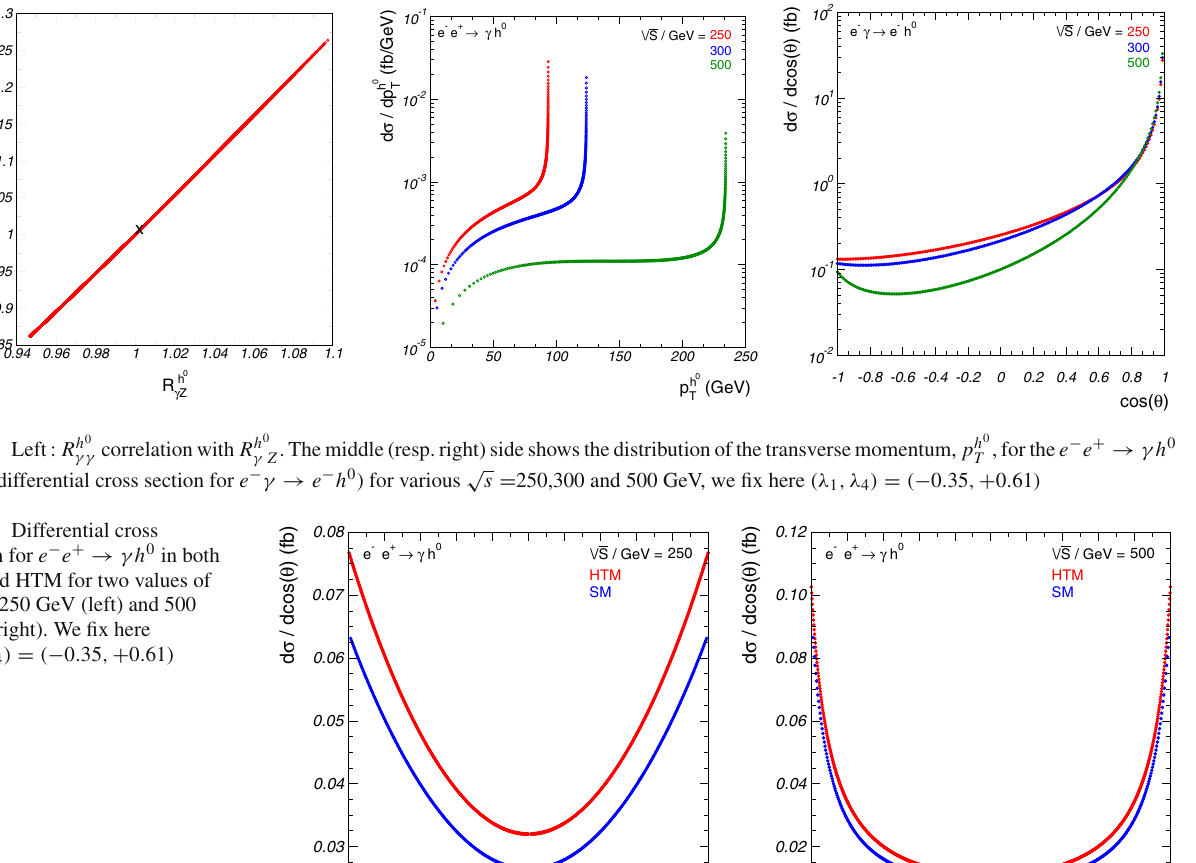
, for the e − e + → γ h 0 T